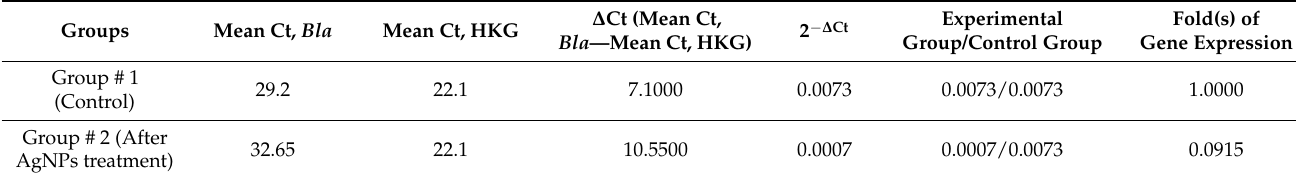
Table 7. Comparison of Bla gene’s fold expressions between the groups.